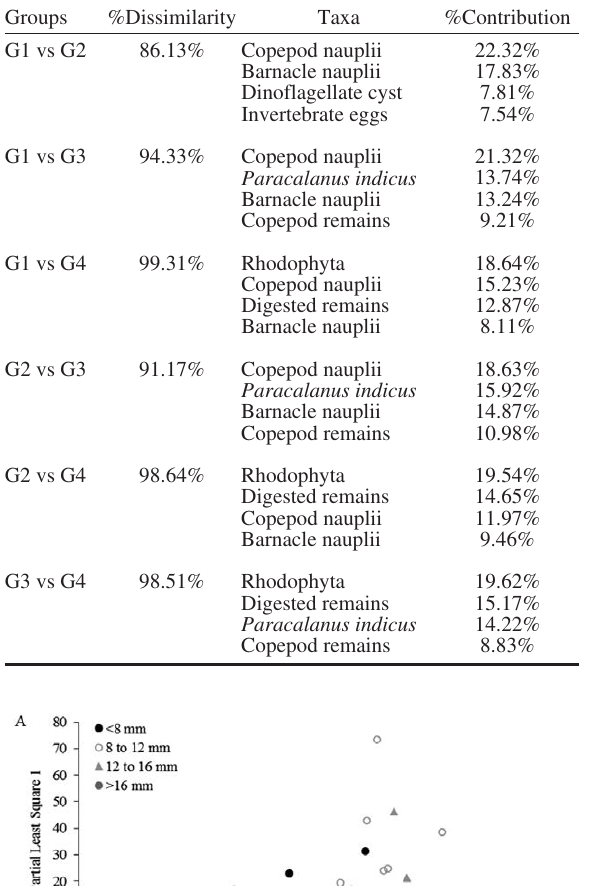
Table 5. – Results of the analysis of percentage similarity (SIM- PER) of the diet composition of the clingfish S. sanguineus. Groups